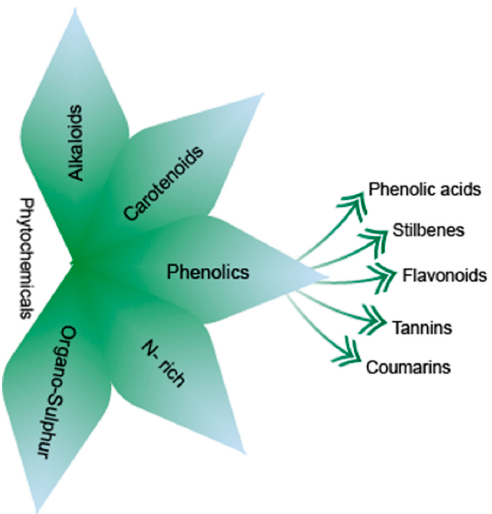
Figure 4. Classification of phytochemicals. alkaloids, carotenoids, n-rich, organo-sulphur compounds, and phenolics, which are further classified as phenolic acids, stilbenes, flavonoids, tannins, and coumarins.